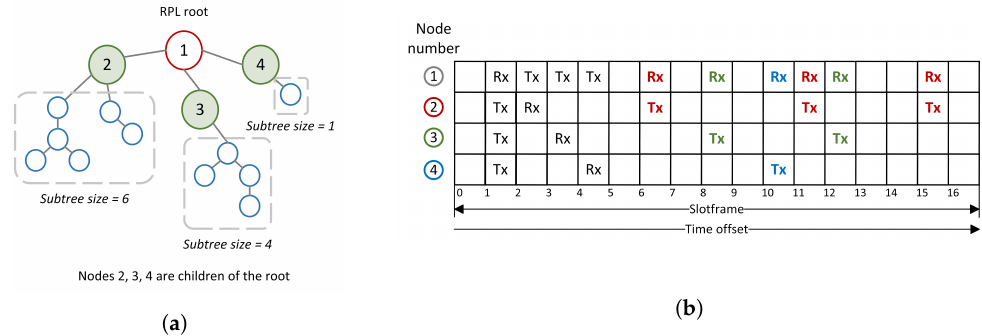
Figure 6. Example of allocation of Rx and Tx slots with the new scheduler. ( a ) The placement of nodes results in a topology with 3 children for the root. Each child has a different subtree size. ( b ) Allocation of Tx and Rx slots based on the topology in ( a ). Table 2. Values of the thresholds used for exemplifying the allocation of additional time